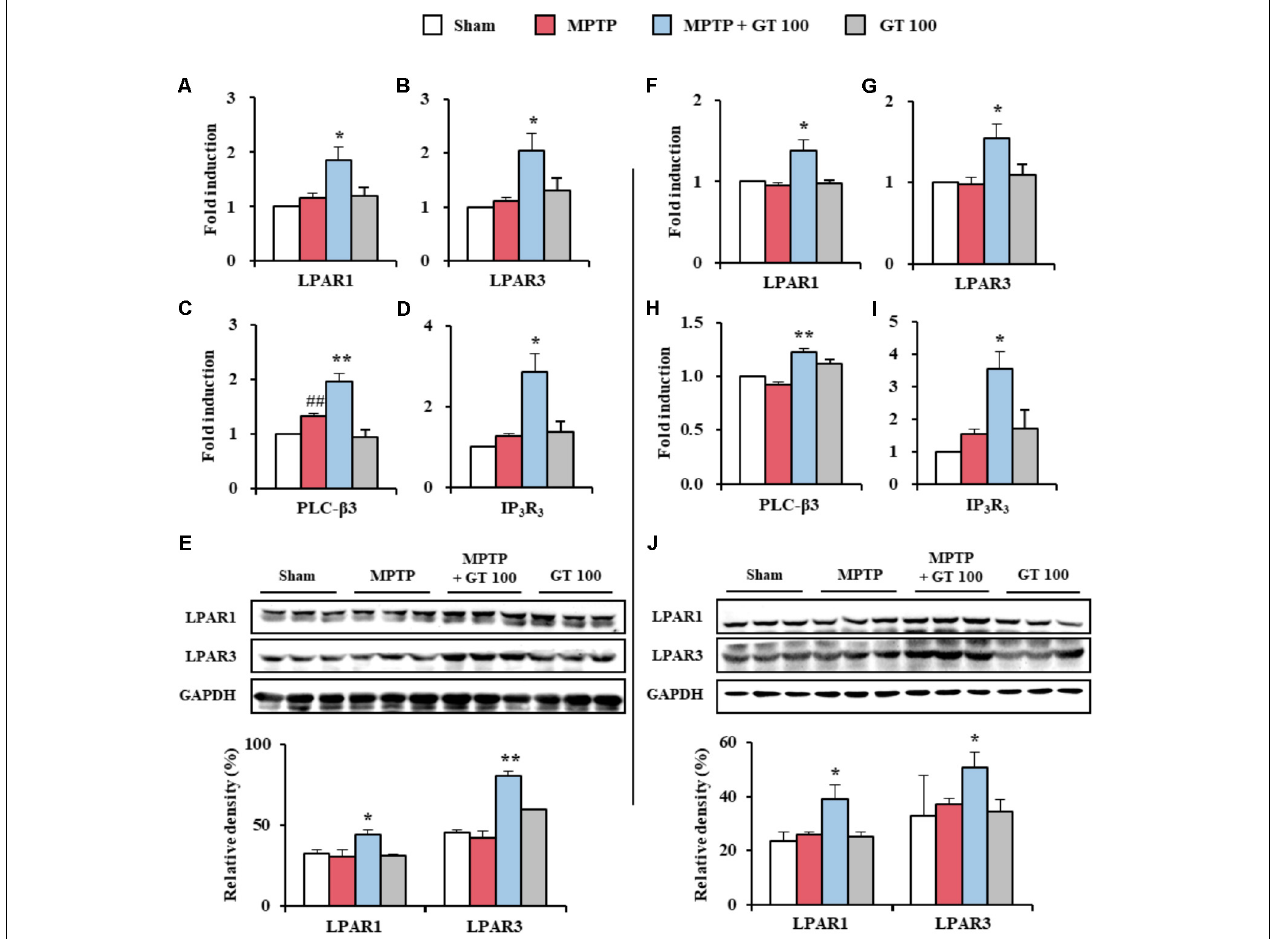
FIGURE 6 | Gintonin activates LPAR1 and 3 signaling pathways in the SNpc and striatum after MPTP injection. (A–J) SNpc and striatum sample from each group ( n = 3 per group) 7 days after MPTP-injection were quantified by real-time PCR (A–D,F–I) and immunoblot analysis (E,J) to measure the alteration in expression of LPAR 1 and 3 or their downstream molecules. mRNA expression of LPAR1 (A,F) , LPAR3 (B,G) , PLC- β 3 (C,H) , and IP 3 R 3 (D,I) . Protein expression of LPAR1 and 3 (E,J) . The top panels illustrate representative Western blots (E,J) . SNpc (A–E) and striatum (F–J) . ANOVA test; ## p < 0.01 vs. Sham group. ∗ p < 0.05 and ∗∗ p < 0.01 vs. MPTP